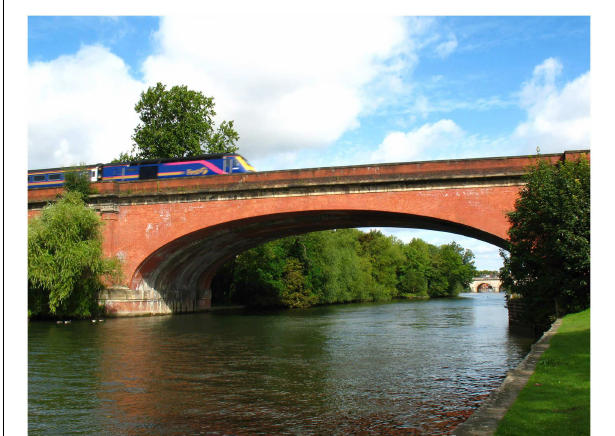
FIGURE 11 | Photograph of a train crossing Maidenhead Bridge. By kind permission of Stephen Dawson. © Stephen Dawson,